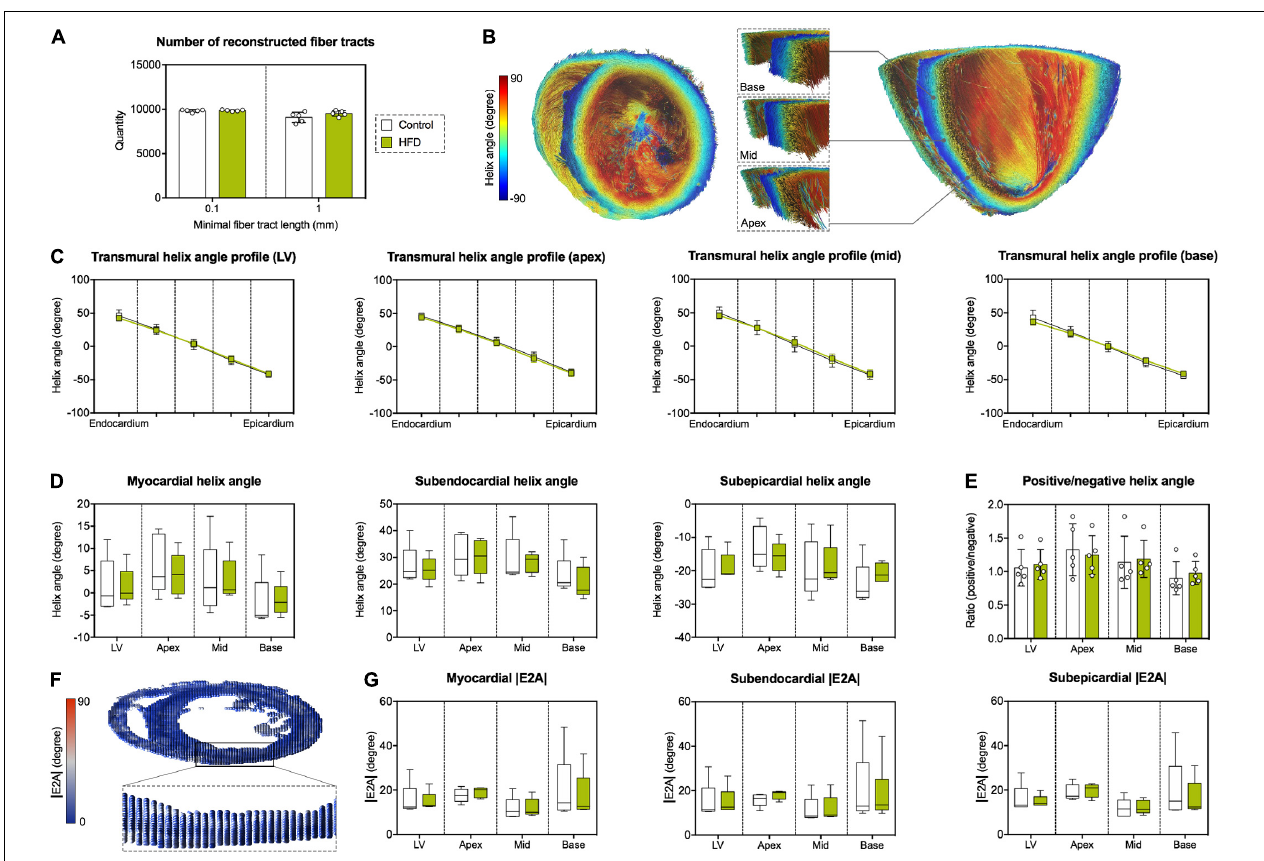
FIGURE 7 | Assessment of left-ventricular microstructure by DT-MRI. (A) Number of reconstructed fiber tracts according to minimal fiber tract length as termination criterion (0.1 and 1 mm, respectively). (B) Representative reconstruction of cardiac fiber tracts with color-coded helix angle in an animal of the HFD group. Left: transverse section of the heart with a view in the direction of the apex. Right: longitudinal section of the heart in anterior-posterior direction with magnified regions of interest at basal, mid-cavity and apical level of the interventricular septum. (C) Transmural helix angle profiles in the LV and different myocardial segments. (D) Helix angles values in the different myocardial layers and segments. (E) Ratio of fiber tracts with a positive helix angle to fiber tracts with a negative helix angle in the different myocardial segments. (F) Visualization of the diffusion tensor in the cardiac short axis at mid-cavity level using superquadric glyphs. Color-coding corresponds to absolute sheetlet angle values (|E2A|). (G) Analysis of |E2A| in the different myocardial layers and segments. Mean ± SD (C,E) or median and quartiles with 95% confidence interval (D,G) ; n = 5 per